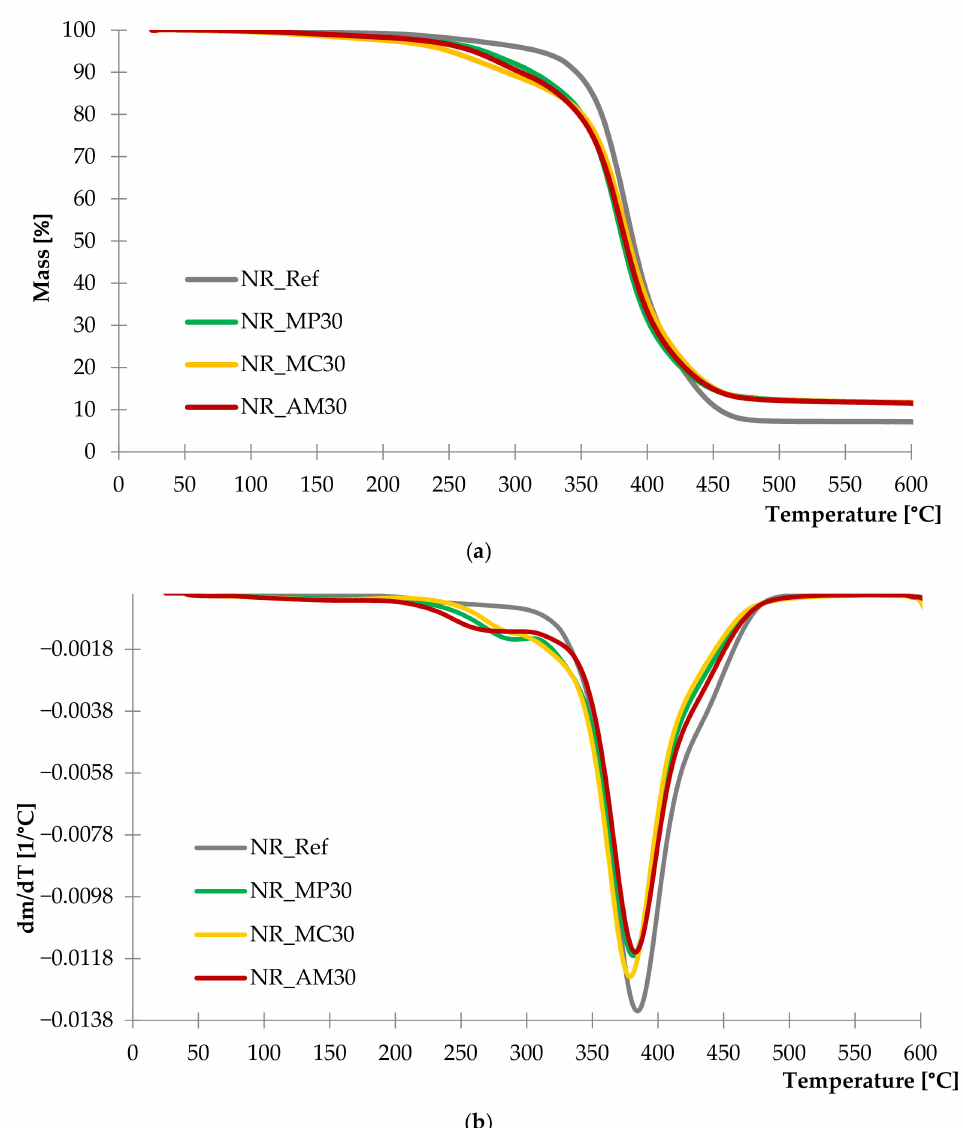
Figure 9. TG ( a ) and DTG ( b ) curves of composites filled with 30 phr of peppermint (NR_MP30), German chamomile (NR_MC30) and yarrow